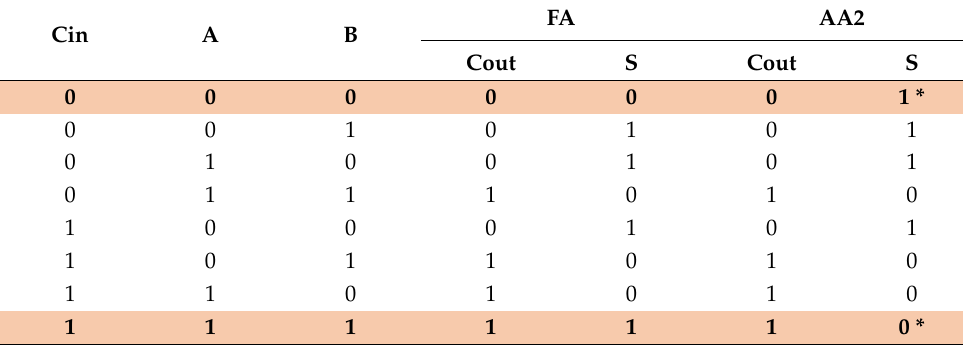
Figure 8. Approximate Adder (AA2). Table 3. Truth table of FA and AA2 .